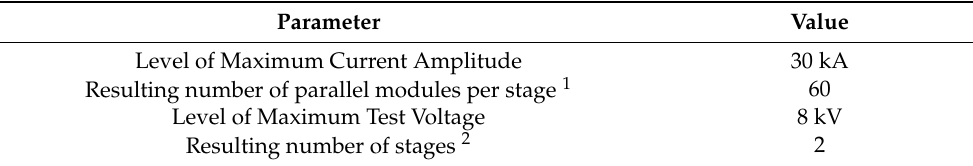
Table 1. Design requirements for demonstrator high-power test circuit and derivation of the corre- spondingly necessary number of test circuit stages and number of test circuit modules per stage.